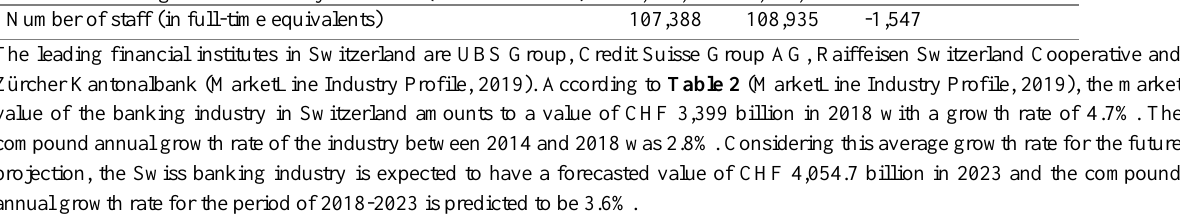
Table 2: Swiss banking industry value 2014-2018 (MarketLine Industry Profile, 2019. pg.